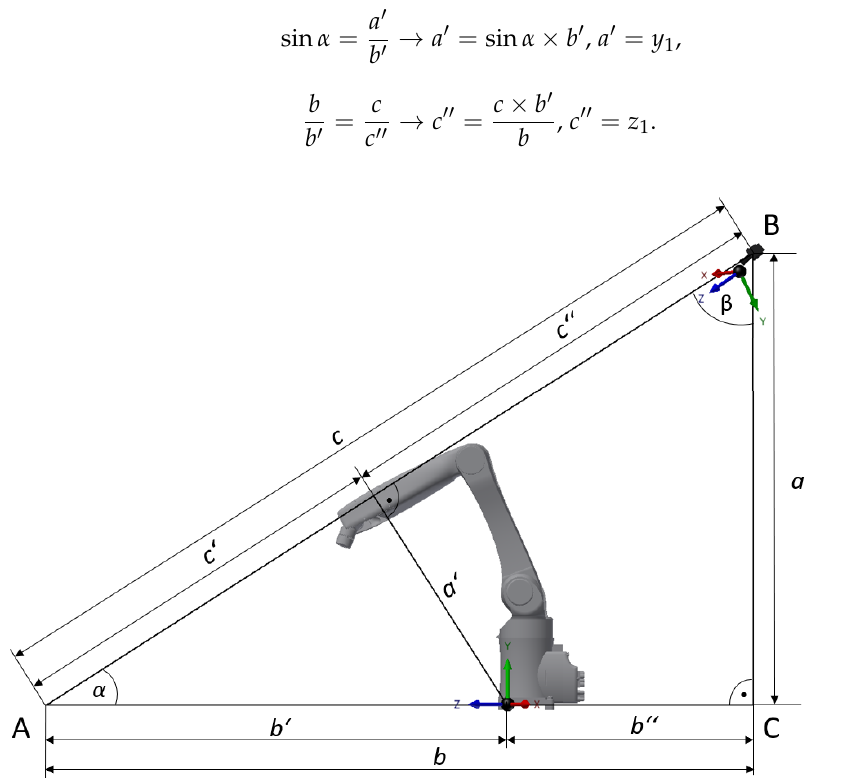
Figure 9. Side view of the workplace for the relative positions of the robot and camera coordinate